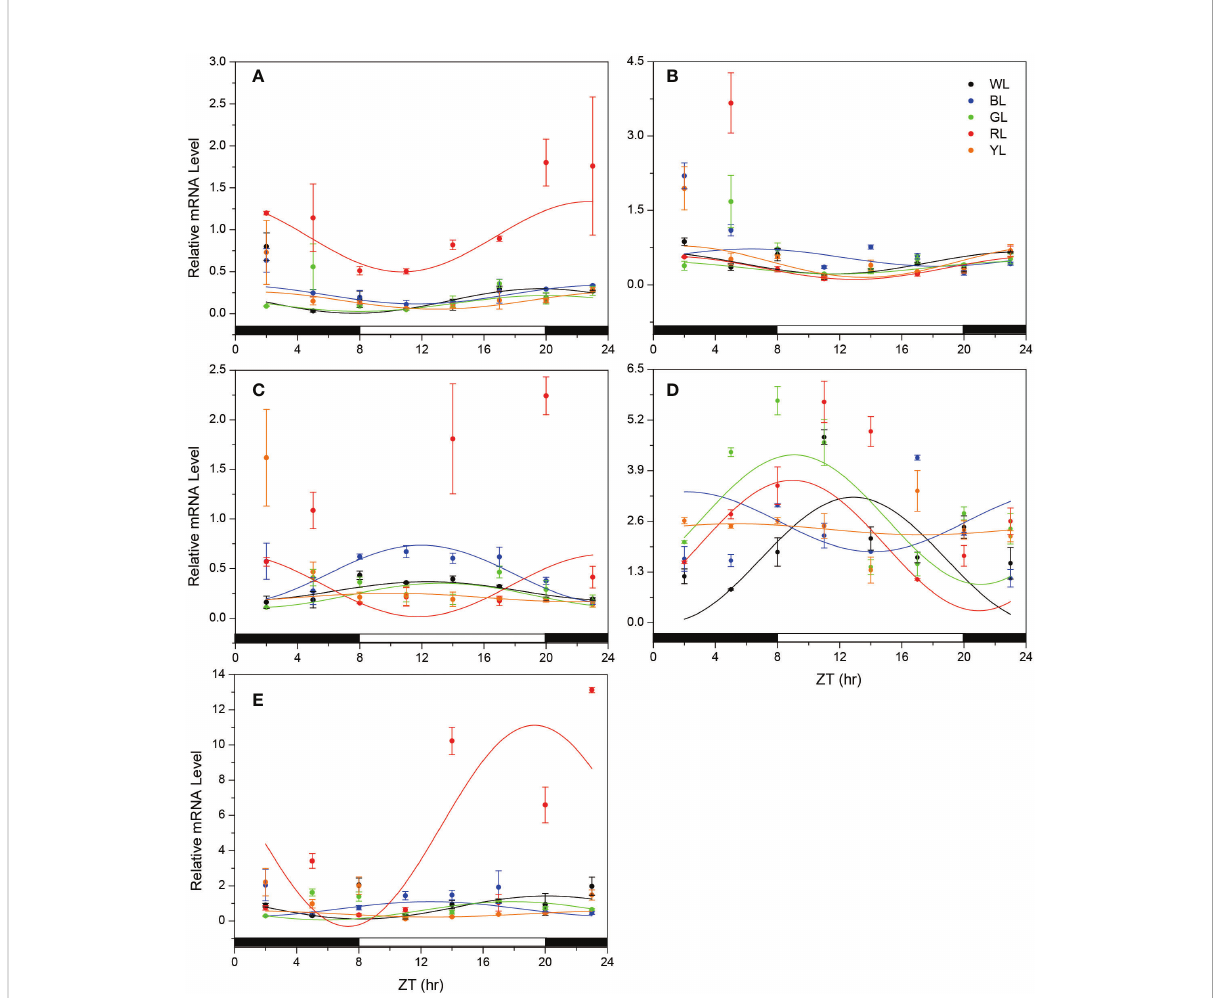
FIGURE 3 Temporal changes in the mRNA levels of clock genes and Aanat2 in the fi sh brain under different light treatments. (A) Clock , (B) Bmal1 , (C) Per2 , (D) Cry1 , (E) Aanat2 . The horizontal white bar on each fi gure represents the light period, and the black bar represents the dark period. The data is shown as the mean ± SEM. N = 3 brains per time point. The curve indicates the best fi t to the points by cosinor analysis. ZT, zeitgeber time; WL, white light; BL, blue light; GL, green light; RL, red light; YL, yellow